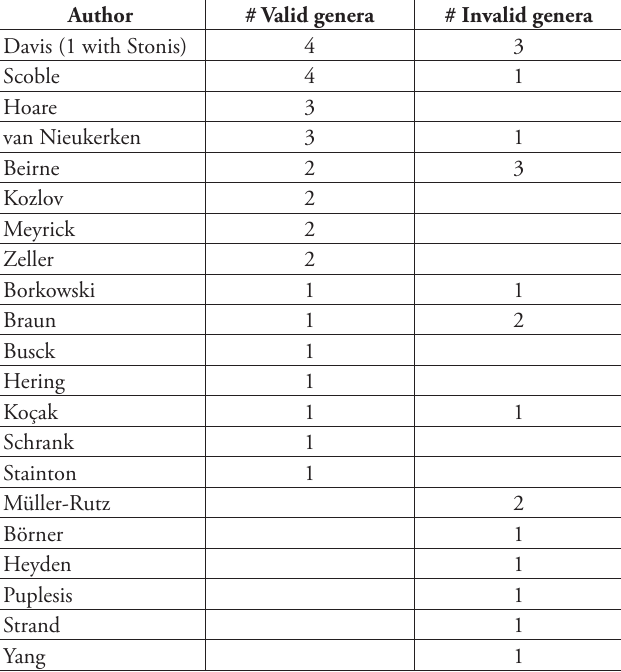
Table 2. Number of genera of Nepticuloidea named per author, including replacement